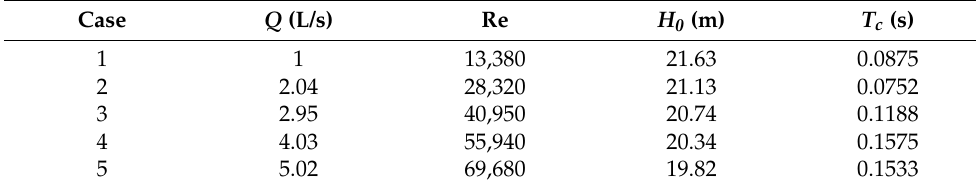
Table 1. Experimental settings